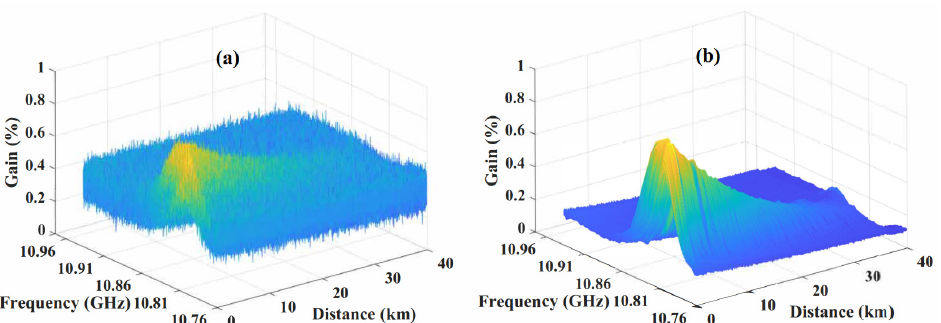
Figure 4. GS image from raw BGS data ( a ) and by QWT image denoising ( b ).